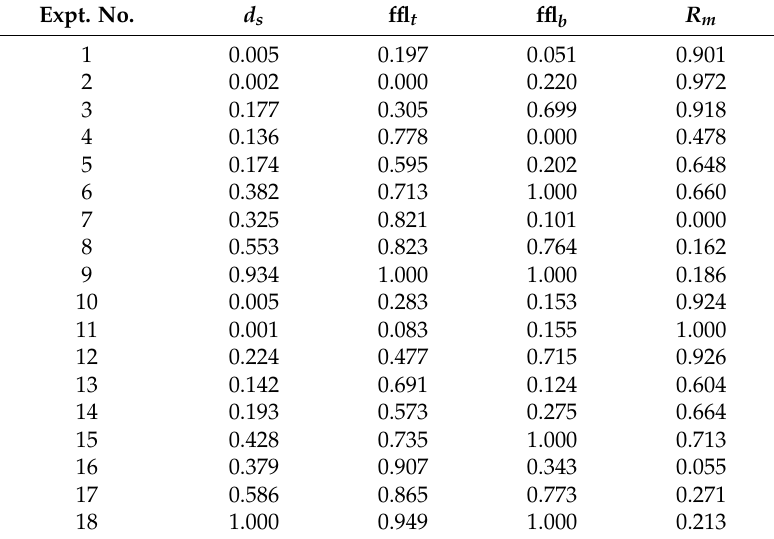
Table 5. Deviation from the normalized values for each output